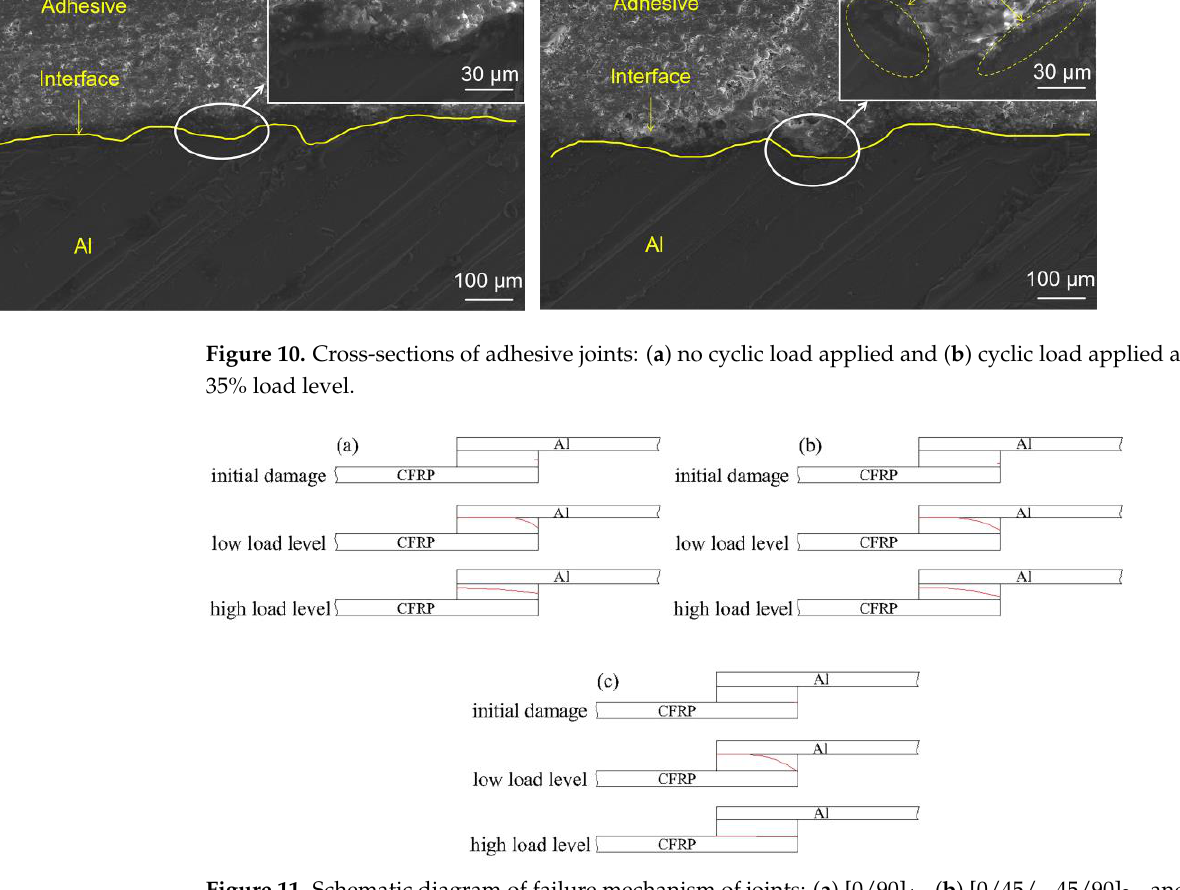
Figure 11. Schematic diagram of failure mechanism of joints: ( a ) [0/90] 4s , ( b ) [0/45/ − 45/90] 2s , and ( c ) [45/ − 45] 4s.